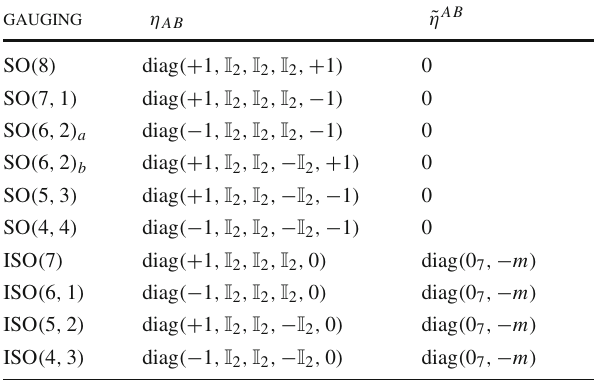
Table 3 Matrices η AB and ˜ η AB specifying the SO ( p , q ) and ISO ( p , q ) gaugings of maximal supergravity